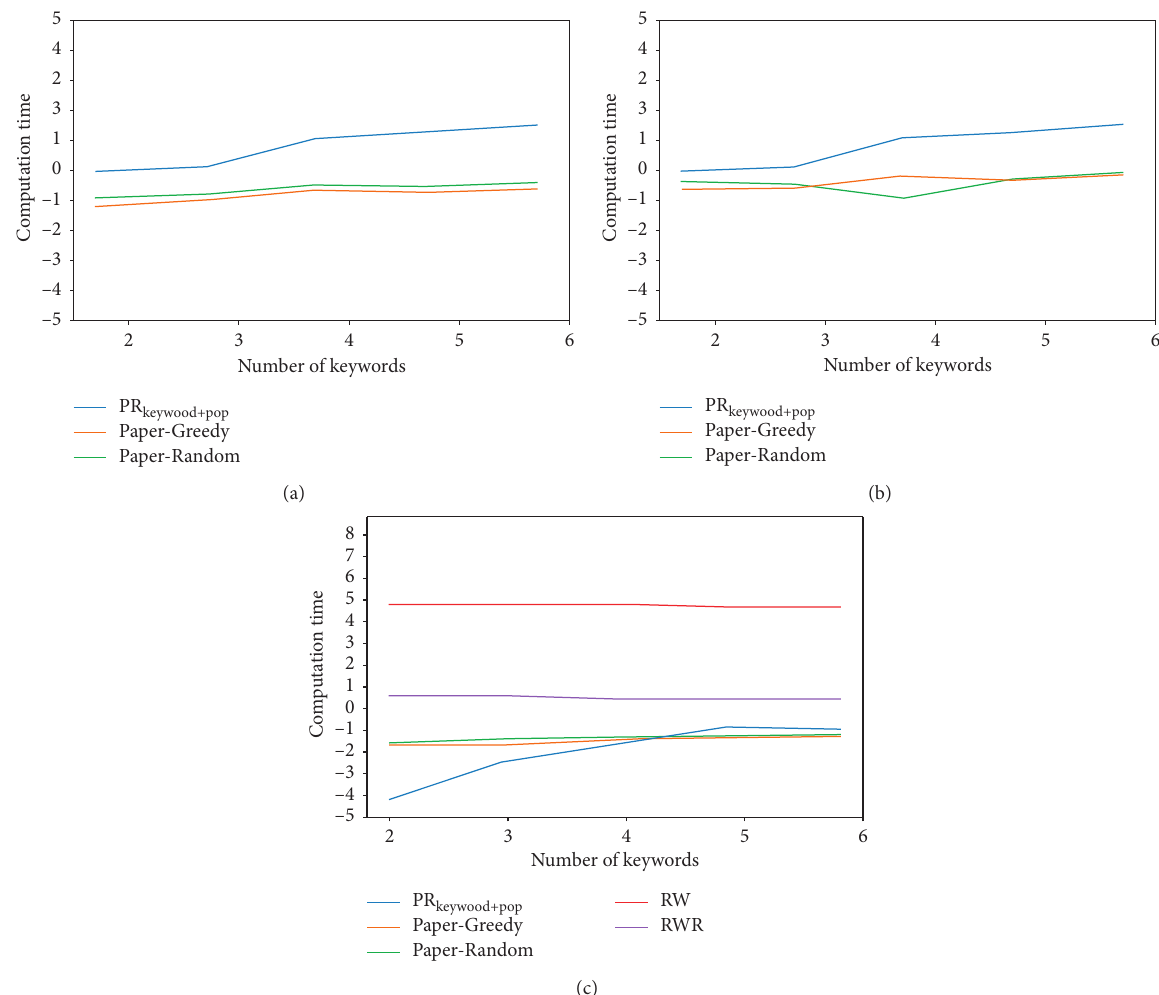
Figure 11: The computation time of different approaches: (a) set A, (b) set B, and (c) set C.